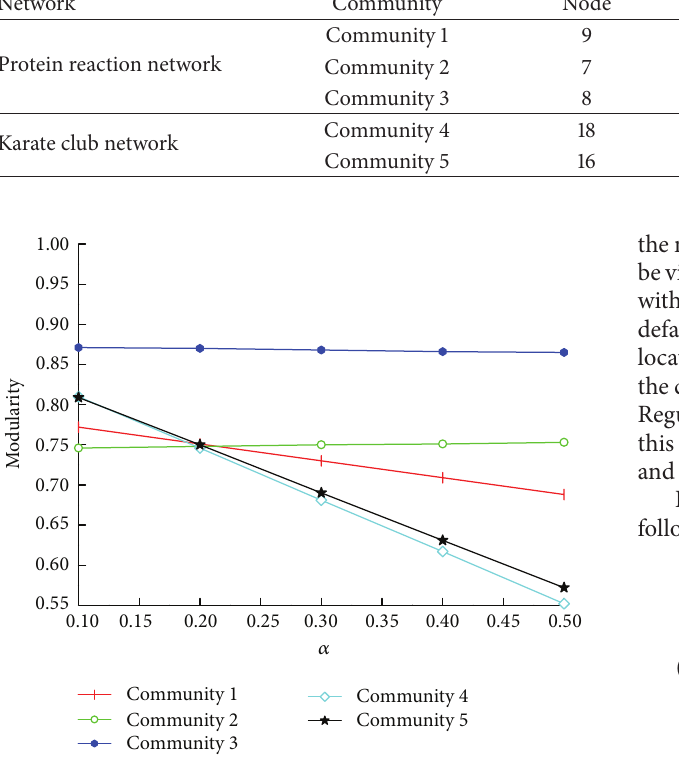
Figure 6: The allocation parameter test